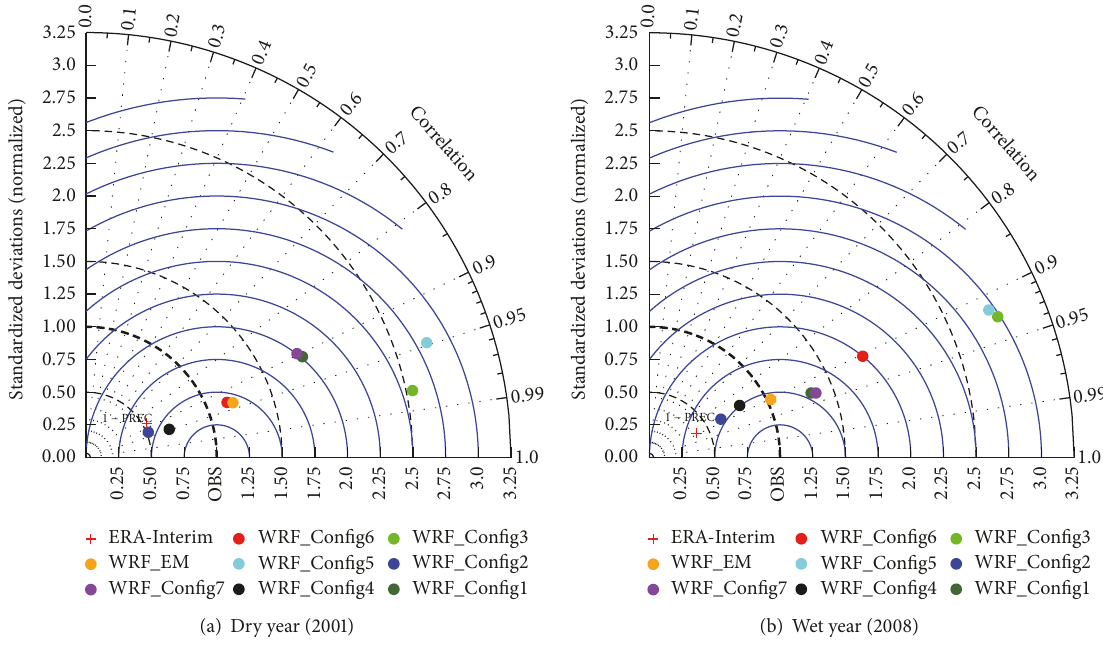
Figure 8: Taylor diagram showing the statistical summary for the northern zone for the (a) dry year (2001) and (b) wet year (2008).